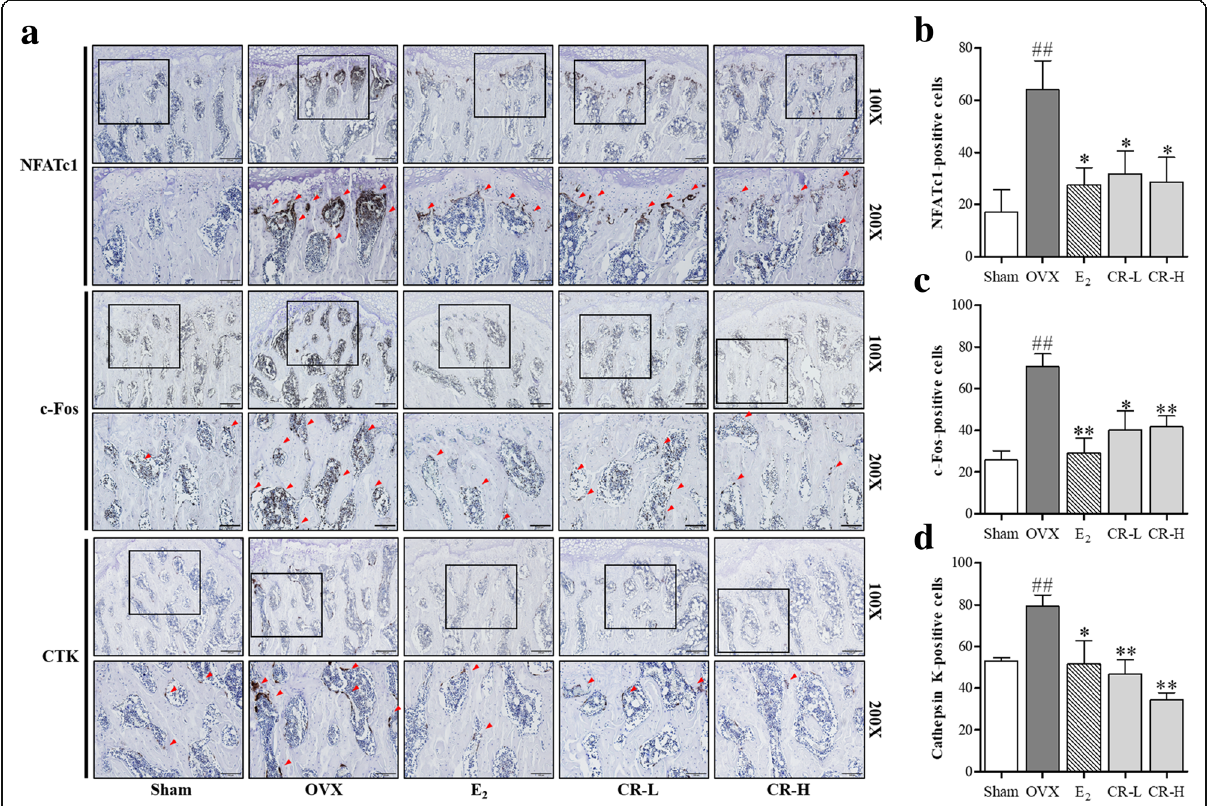
Fig. 9 Effect of CR on the expression of NFATc1, c-Fos and CTK in OVX-induced femur. a Immunohistochemistry staining of NFATc1, c-Fos and CTK was conducted. One representative femur from each group was captured using a light microscope. The red arrowheads indicate each indicators-positive cells. (100X and 200X magnification, Scale bars are 200 and 100 μ m, respectively). b Quantification of NFATc1-positive cells, c c- Fos-positive cells and d CTK-positive cells in femur were examined. Data represent the mean ± S. E of each experimental groups. ## p < 0.01 compared with the Sham and ** p < 0.01, * p < 0.05 compared with